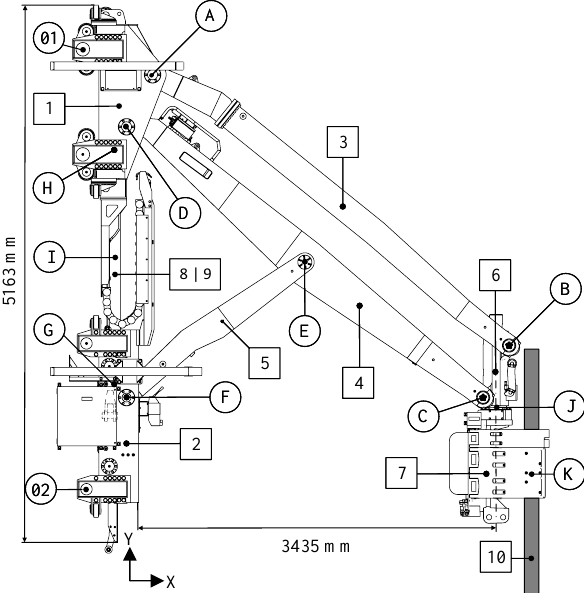
Figure 5: Gripper arm in fully extended position - courtesy of Cameron Sense AS.